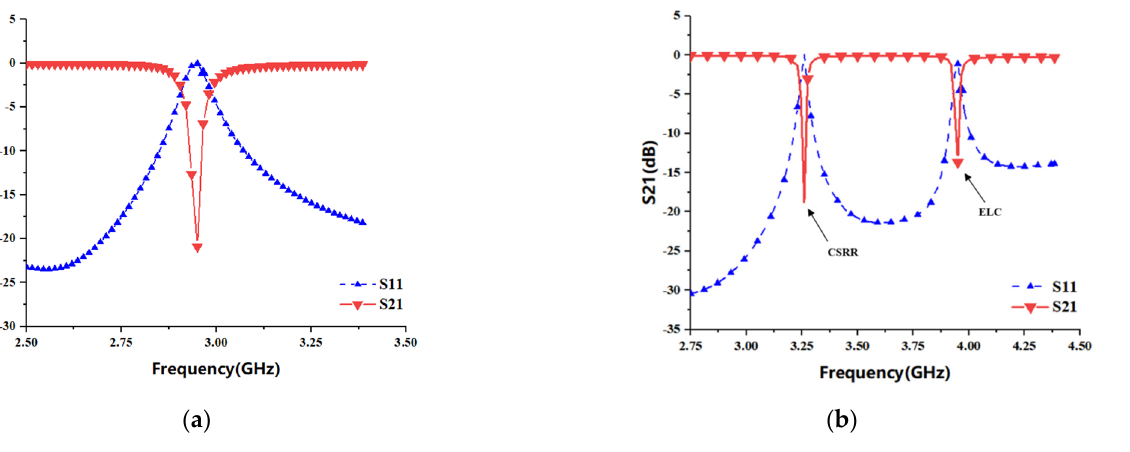
Figure 3. Chipless RFID tag resonance response curve: ( a ) CSRR resonance unit S11 and S21 response curve; ( b ) ELC and CSRR resonance unit S11 and S21 response curve.